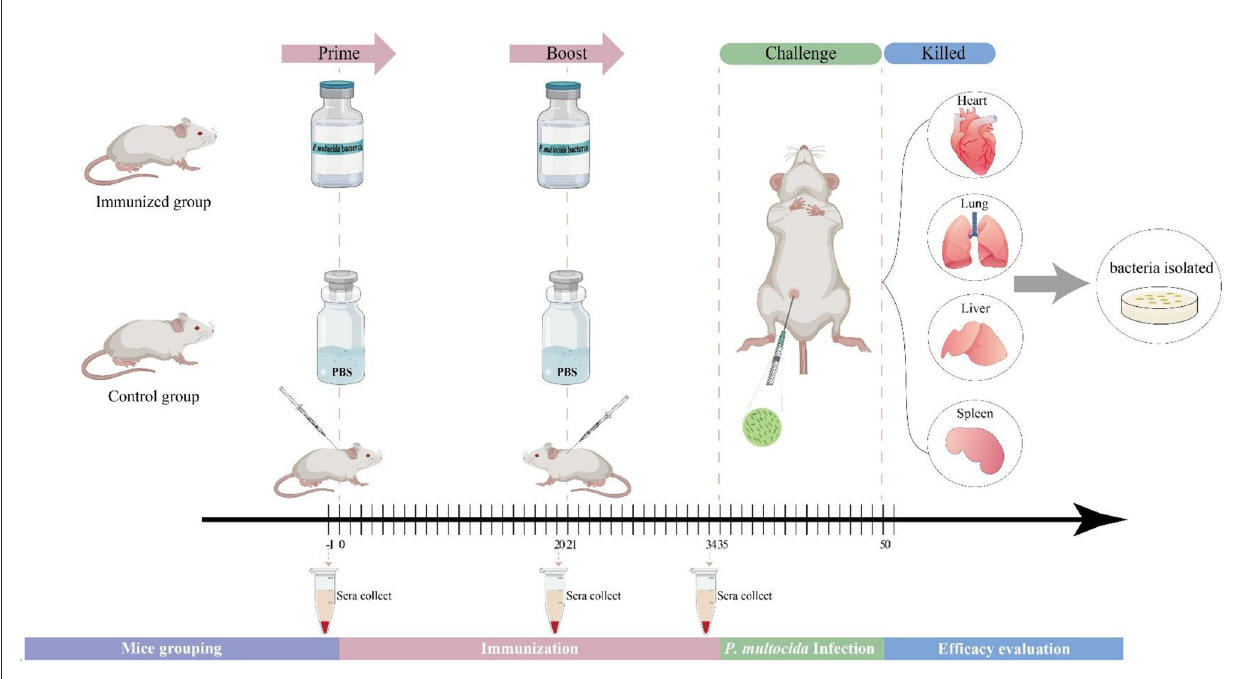
FIGURE1 Flow chart of the vaccination, infection, and evaluation procedures of P. multocida